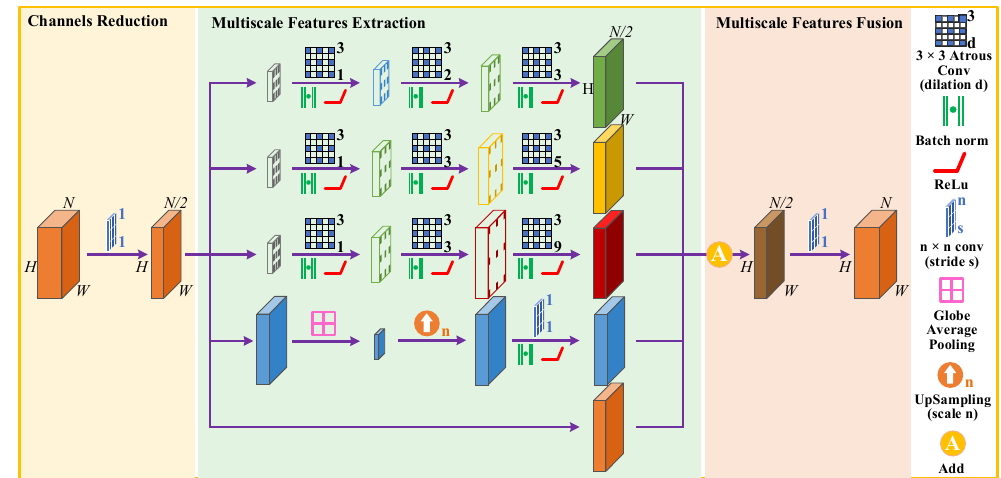
Figure 4. The architecture of the continuous atrous convolution pyramid (CACP) module.